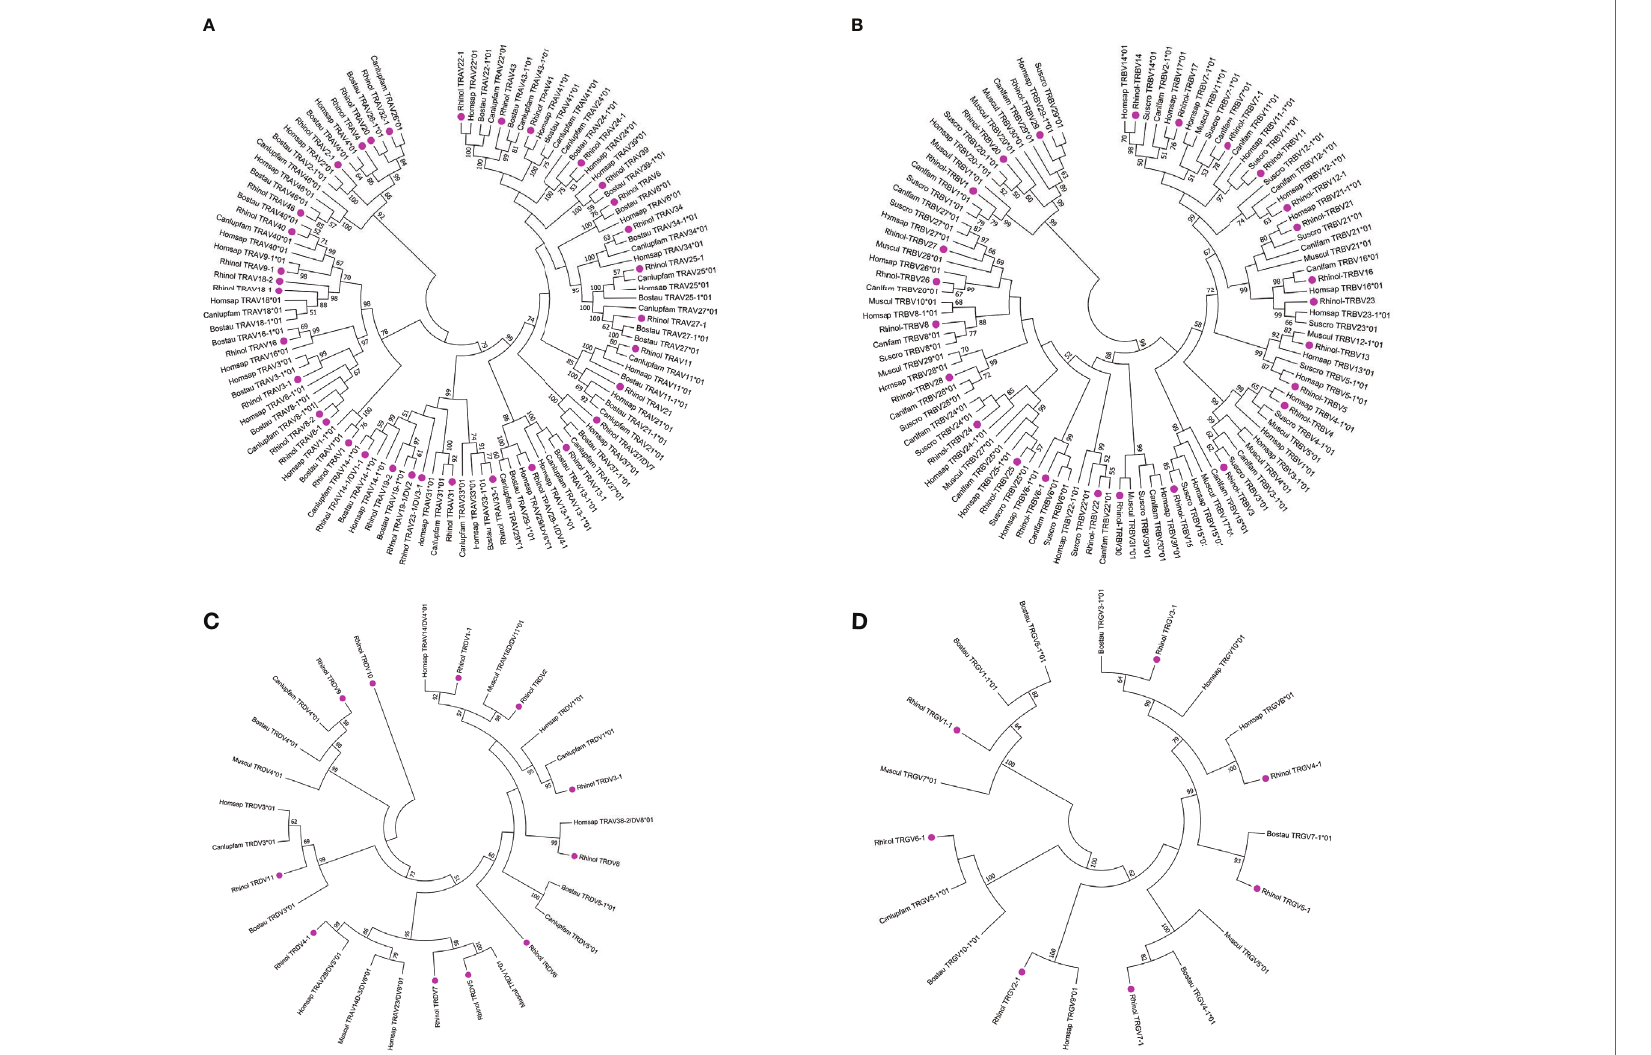
FIGURE 5 | Phylogenetic analysis of TRAV (A) , TRBV (B) , TRDV (C) , TRGV (D) genes. Unrooted trees were constructed using the neighbor-joining method based on V-REGION nucleotide sequences of bats, dogs, humans, mice, and cows. The percentage of the nodes in 1,000 bootstrap replicates are show on the branches. Bat genes are labeled in pink. The international ImMunoGeneTics information system (IMGT) standardized abbreviation for taxon is used: six letters for species ( Rhinolophus ferrumequinum , Rhinol; Homo sapiens , Homspa; Mus musculus , Muscul; Bos taurus , Bostau) and nine letters for subspecies